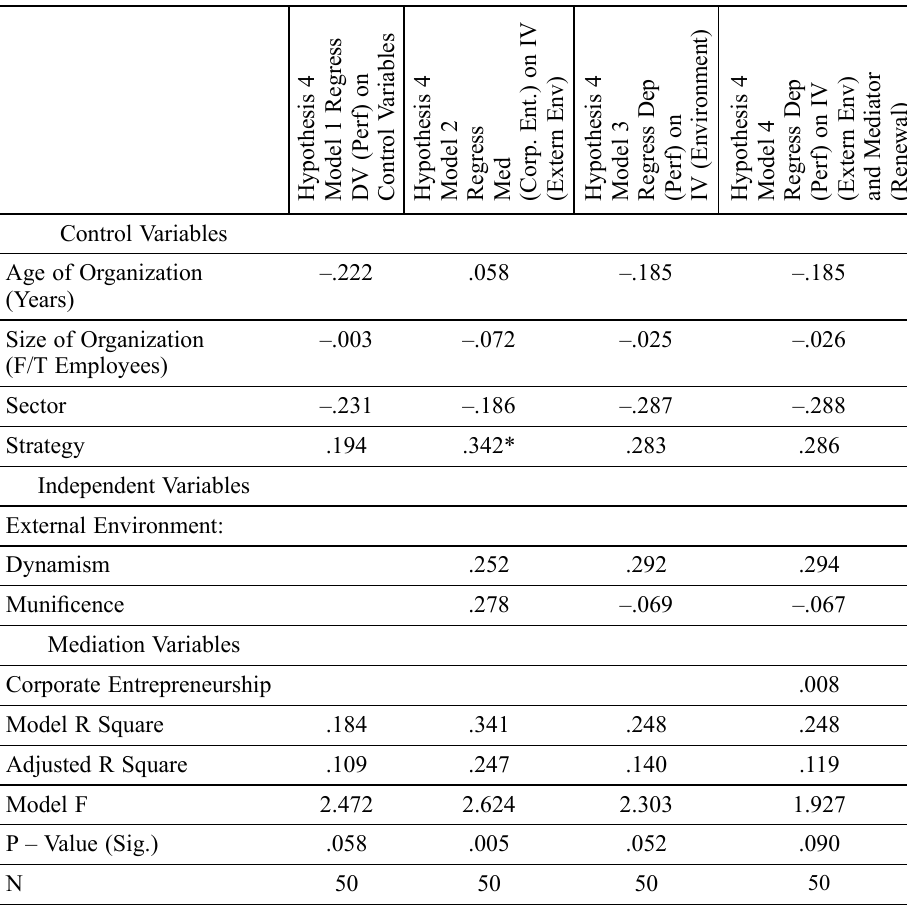
Table 7. Hierarchical regression analysis results – hypothesis